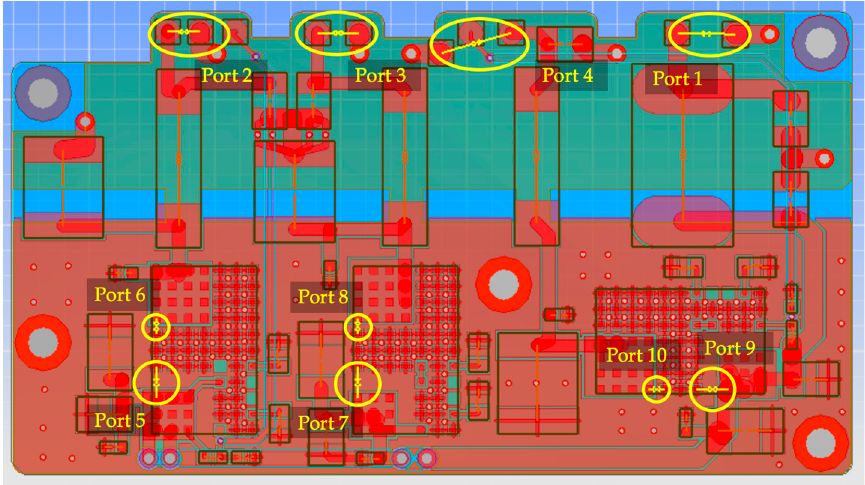
Figure 18. Port definitions of the power supply module instance. Table 2. Parameter settings of each port.